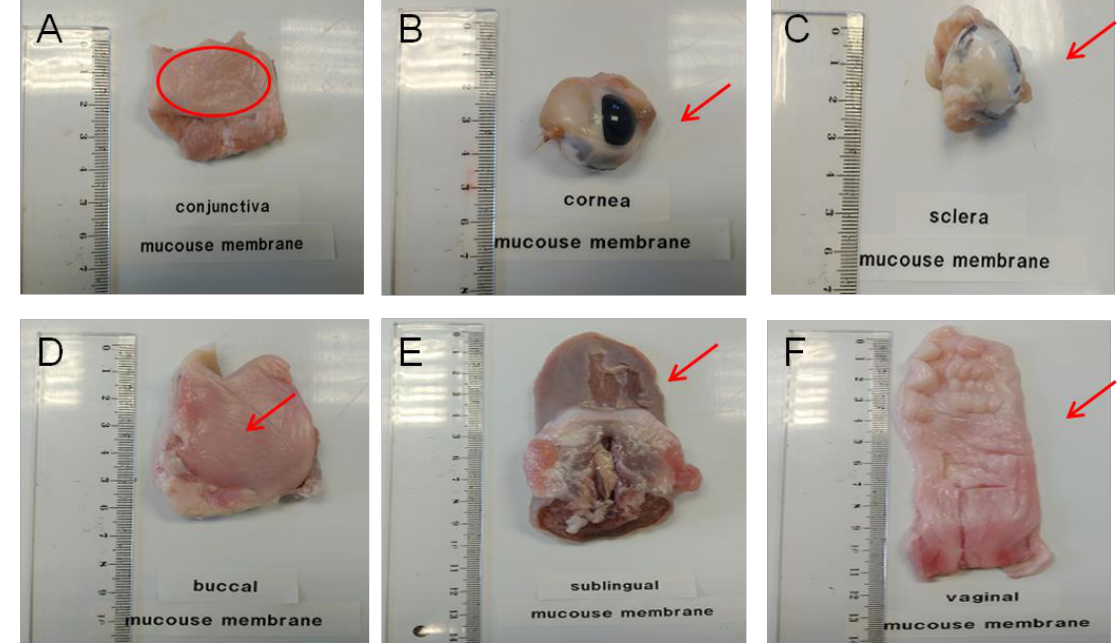
Figure 1. Ex vivo porcine ophthalmic and porcine mucous used as permeation membranes. ( A ): conjunctiva; ( B ): cornea; ( C ): sclera; ( D ): buccal mucous; ( E ): sublingual mucous and ( F ): vaginal mucous.